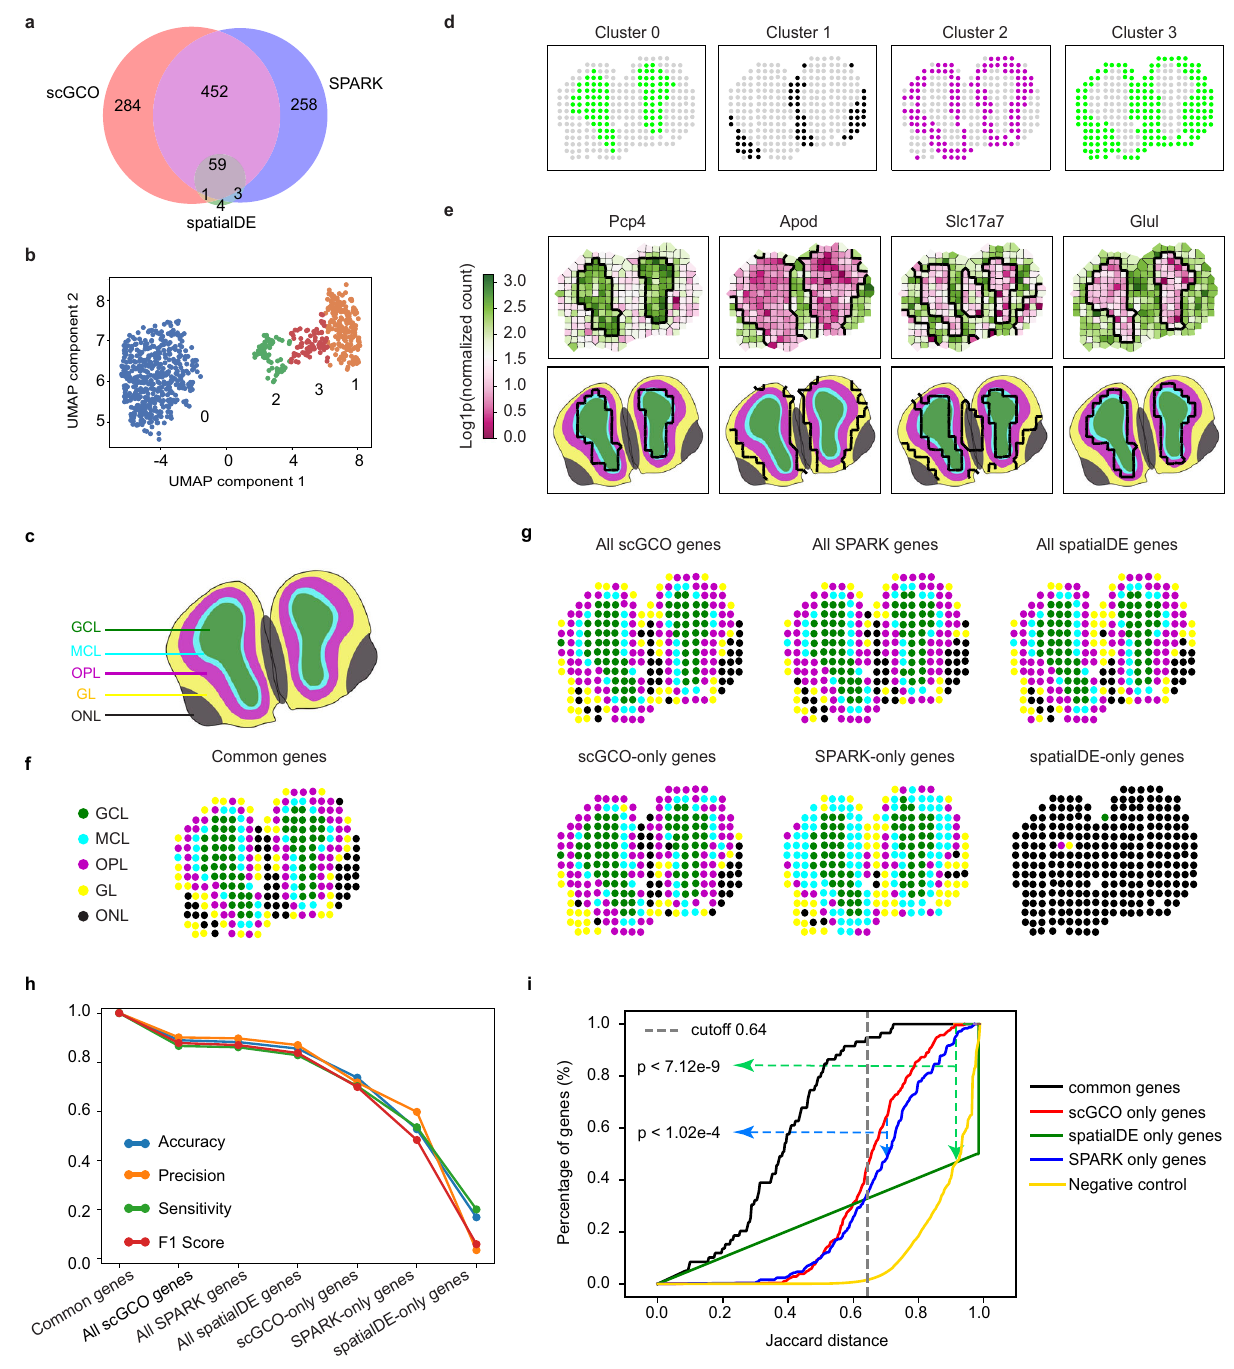
Fig. 3 | Application of scGCO to spatial gene expression data from mouse olfactory bulb. a Venn diagram showing the set relationship among SV genes identi fi ed by scGCO, spatialDE and SPARK (FDR<0.05) from replicate 11 of